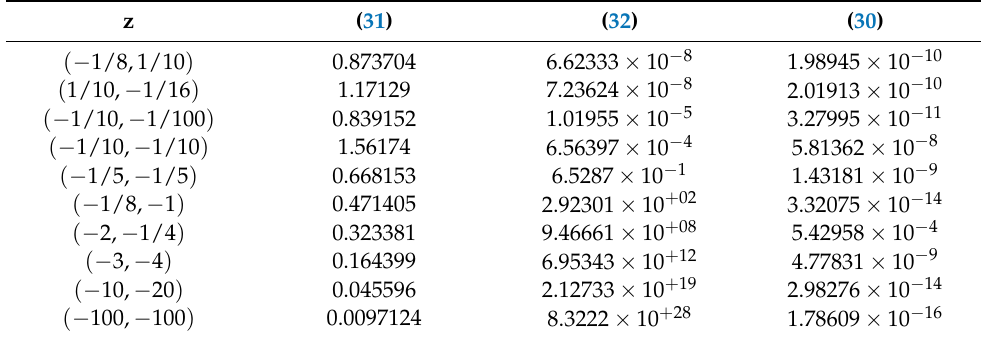
Table 1. Relative error of 10th partial sum and 10th approximants for (( 1 − z 2 ) 2 − 4 z 1 ) − 1/2